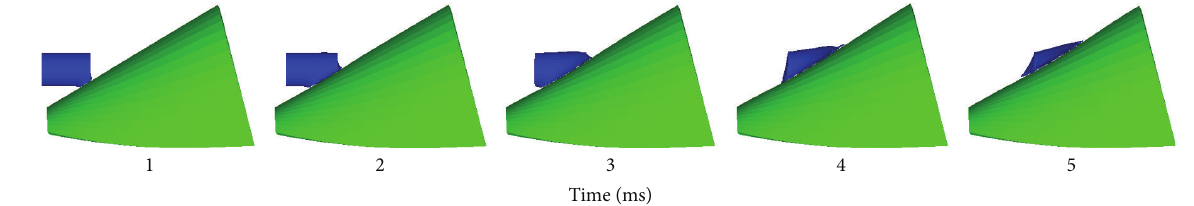
Figure 8: Different stages of deformation of windshield at bird impact velocity of 64.4m/sec.